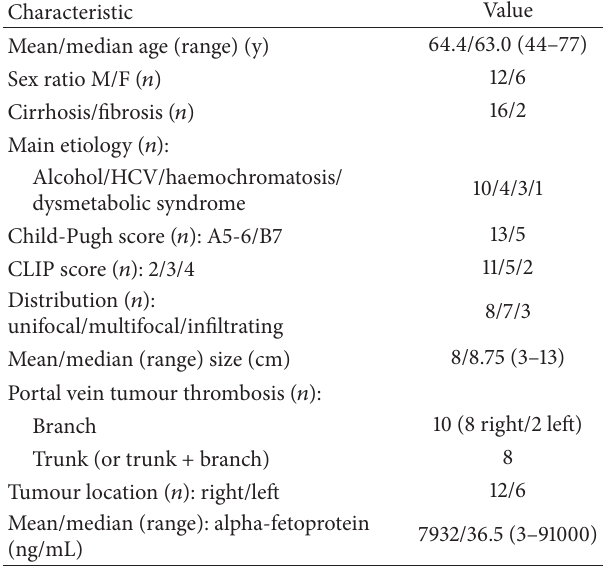
Table 1: Baseline characteristics ( 𝑛 = 18